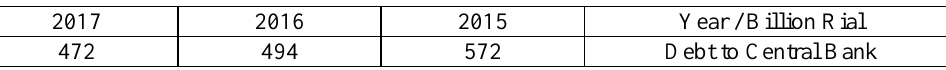
Table3. Debts of Iranian Specialty Banks to Central Bank (1000 billion